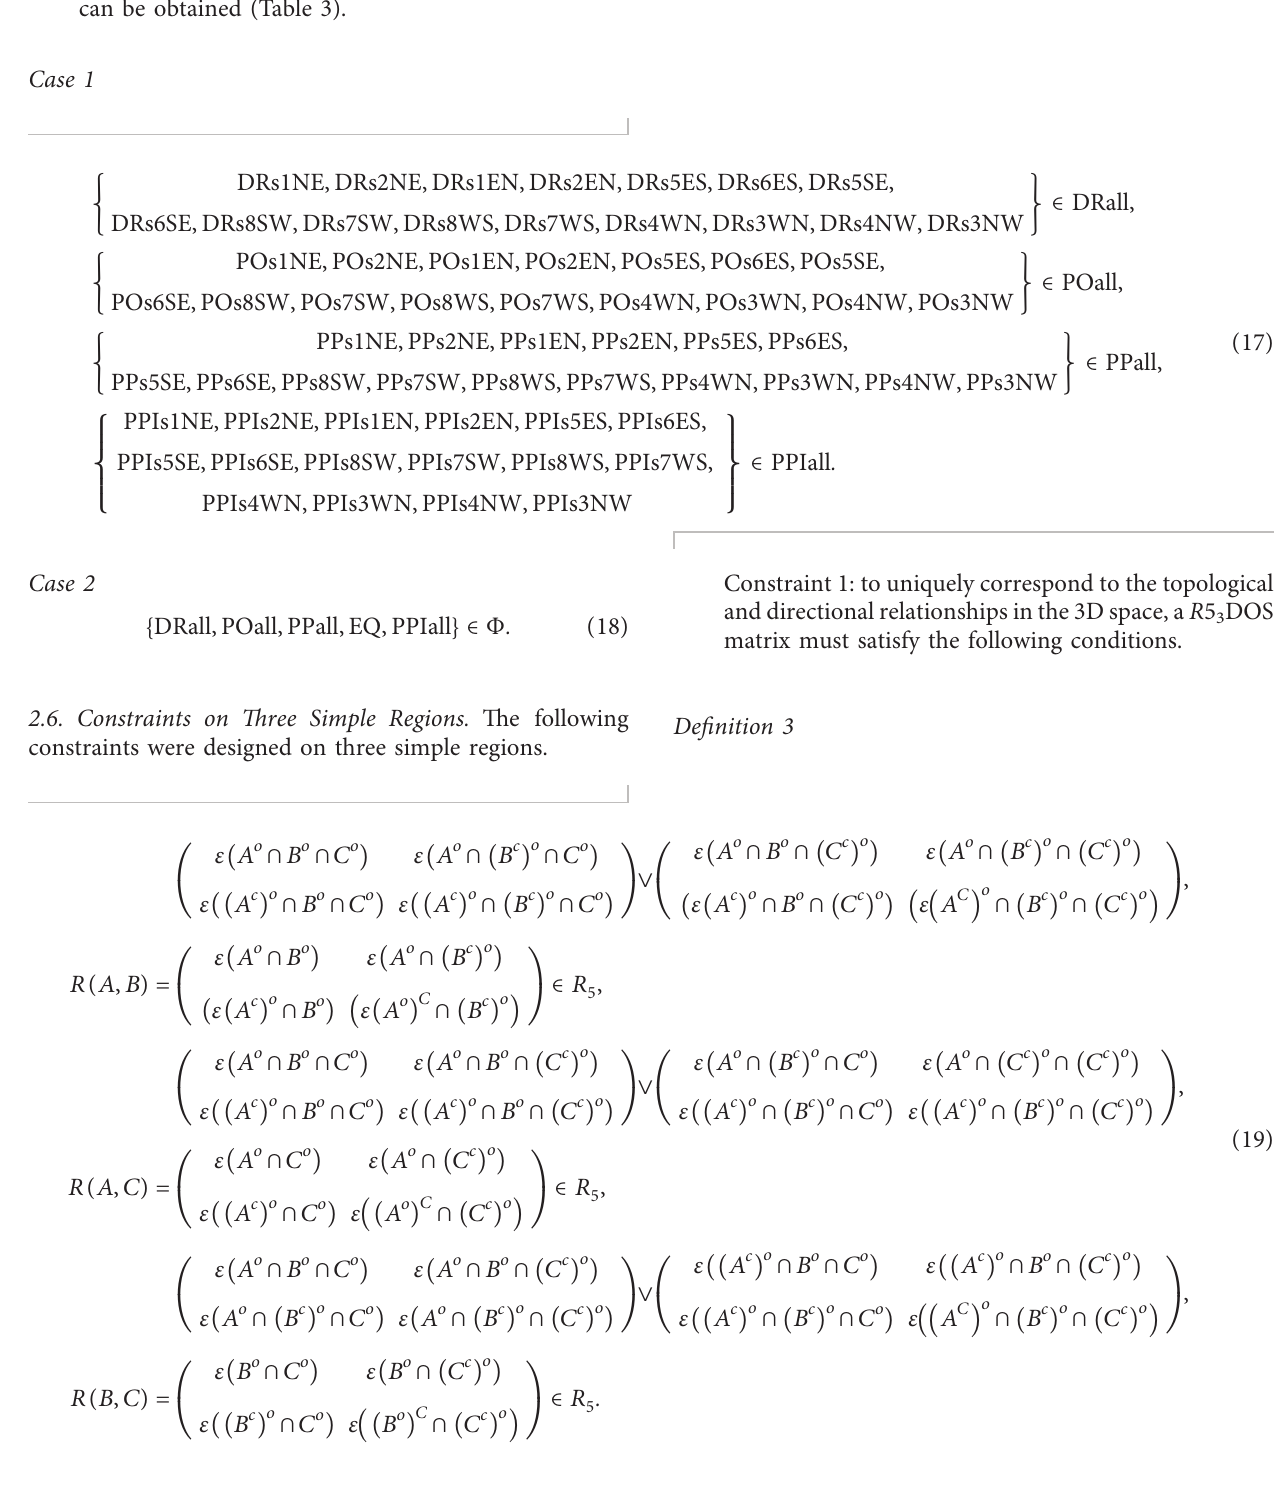
can be obtained (Table 3).